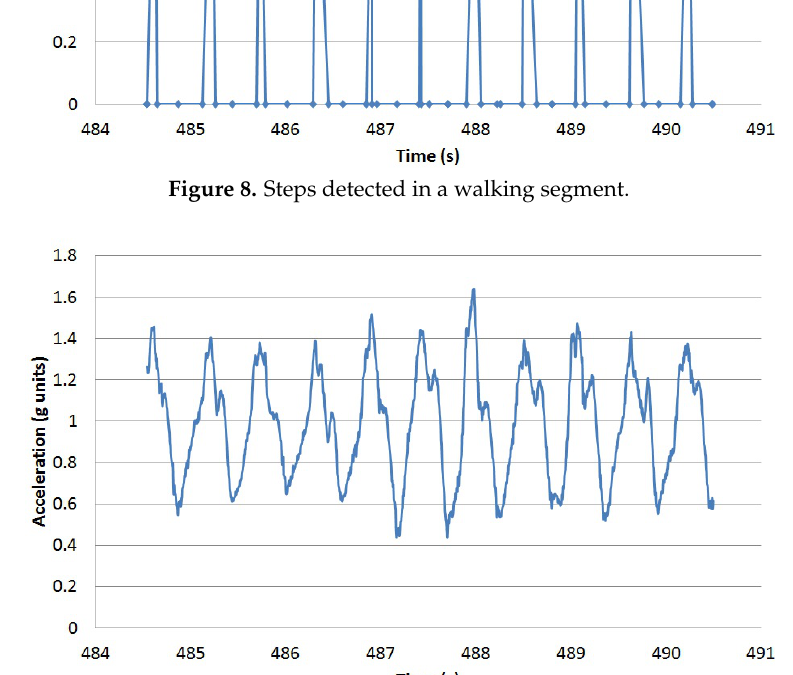
Figure 9. Vertical acceleration for the same segment as in Figure